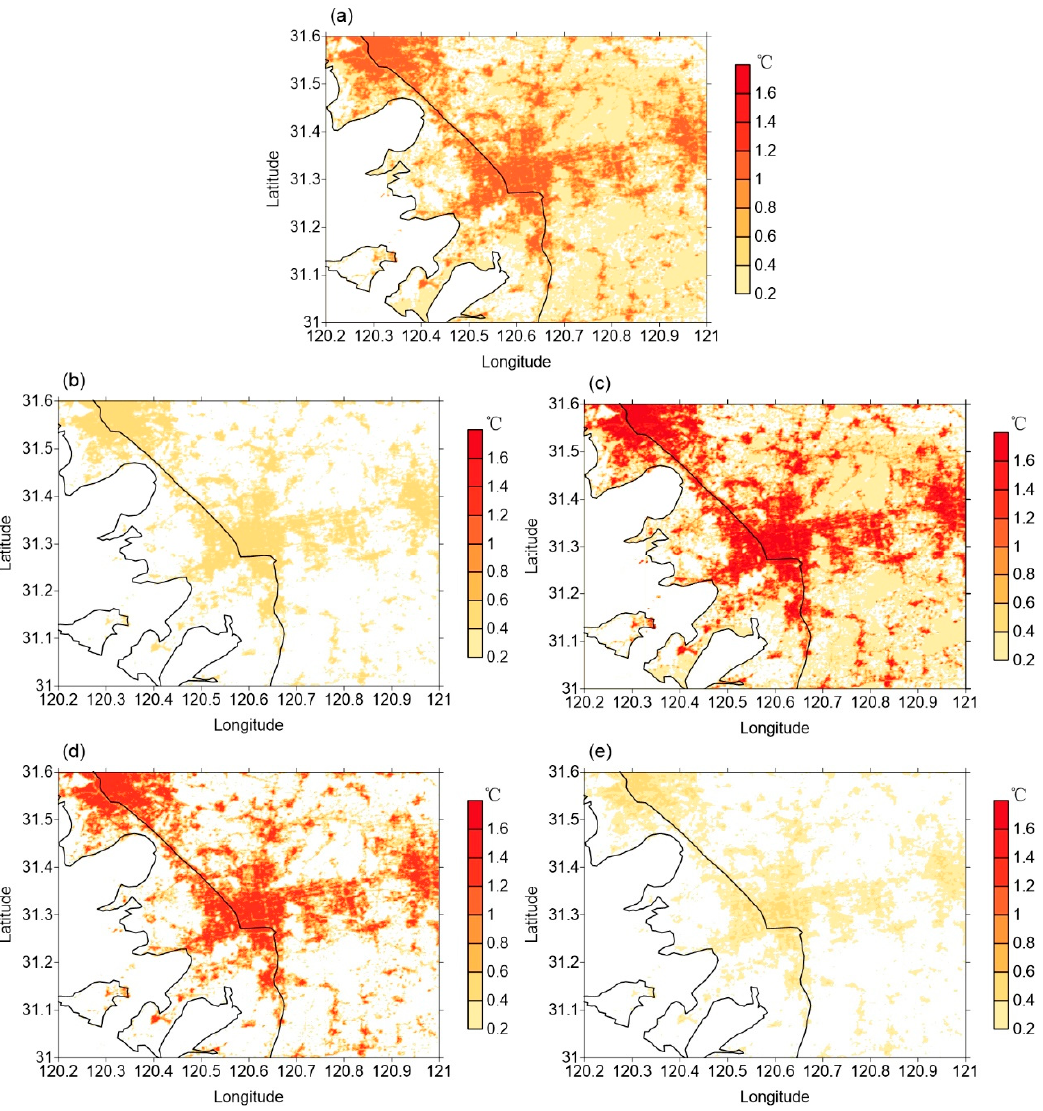
Figure 5. Distribution of annual and seasonal averaged urban heat island intensities: ( a ) annual; ( b ) spring; ( c ) summer; ( d ) autumn; ( e ) winter.